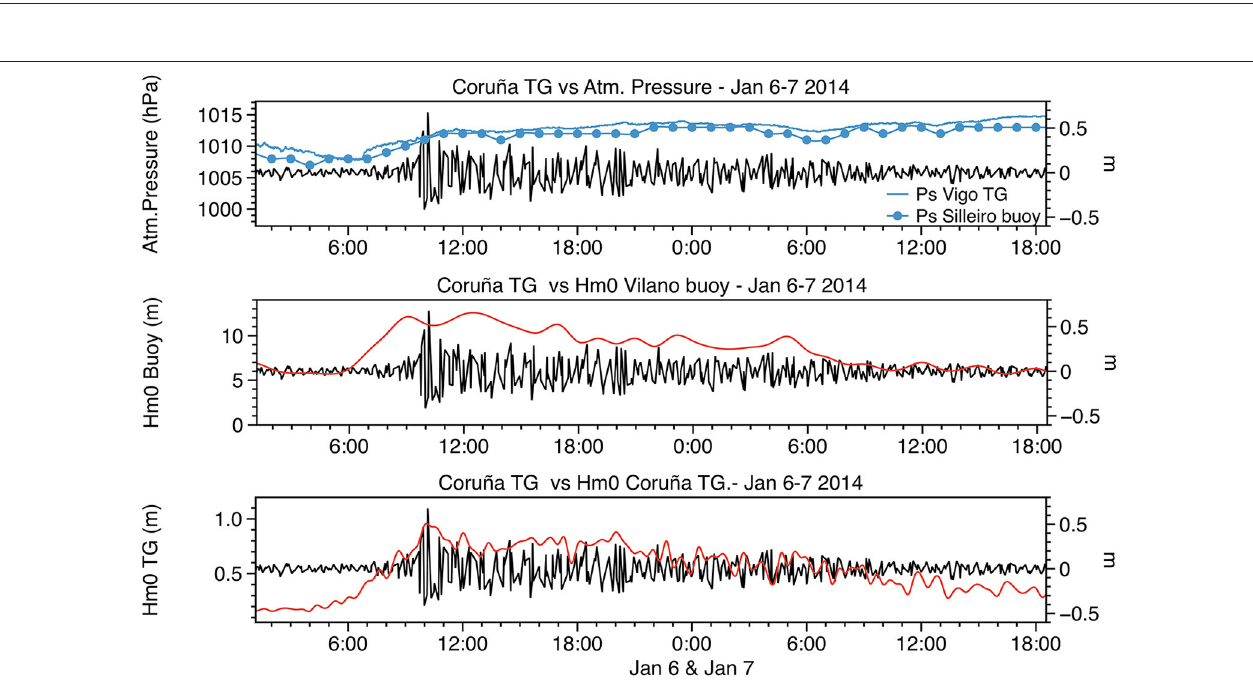
FIGURE 7 | Sea level oscillations on January 6th 2014 at Coruña harbor vs.: top: atmospheric pressure data from Silleiro buoy (hourly values, blue dotted line) and from Vigo tide gauge (1min values, blue line); middle: significant wave height recorded by Vilano buoy (red line); bottom: significant wave height recorded by Coruña tide gauge itself (red line). There is not atmospheric pressure data available from the nearest buoy (Vilano).